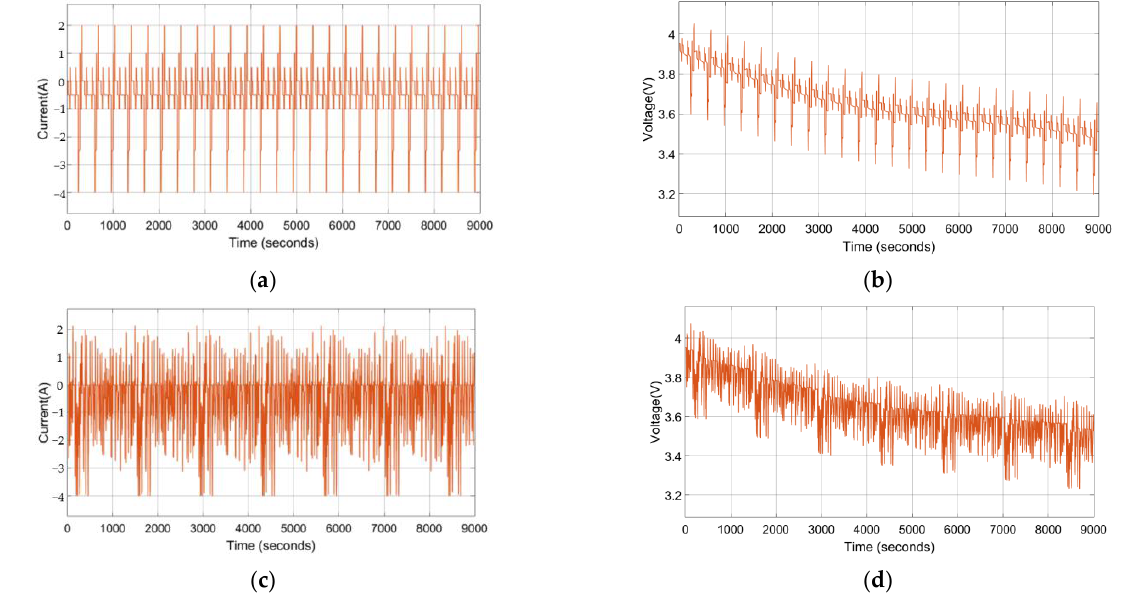
Figure 3. Voltage and current profiles of 18650 Li-ion battery: ( a ) current profile under DST; ( b ) voltage profile under DST; ( c ) current profile under FUDS; and ( d ) voltage profile under FUDS.